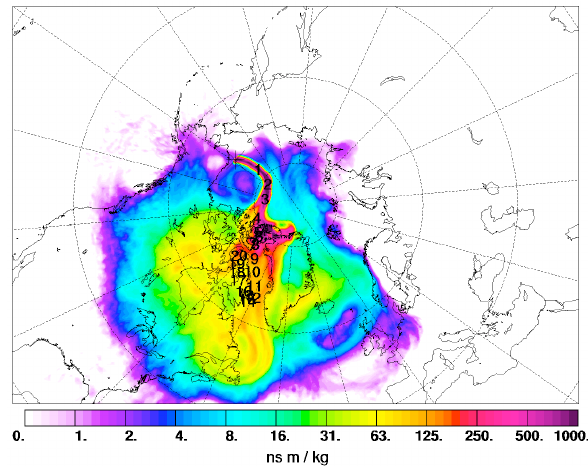
Fig. 11. FLEXPART Lagrangian transport model backward trans- port simulation of 6 × 10 4 air particles initialized at the location of the WP-3D aircraft within the ABL on 16 April 2010 at 00:22UTC. Color scale (logarithmic) is the column-integrated potential emis- sion sensitivity, which is proportional to the cumulative residence time of each particle in a grid cell. Numeric labels show the cen- troid particle location on each